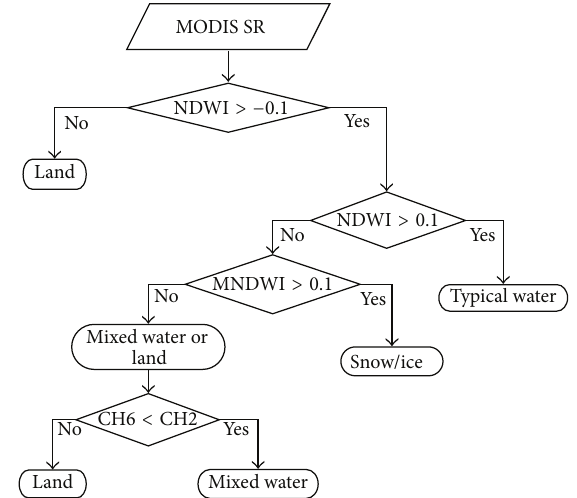
Figure 3: Flow chart of lake detection with multiple water indexes.